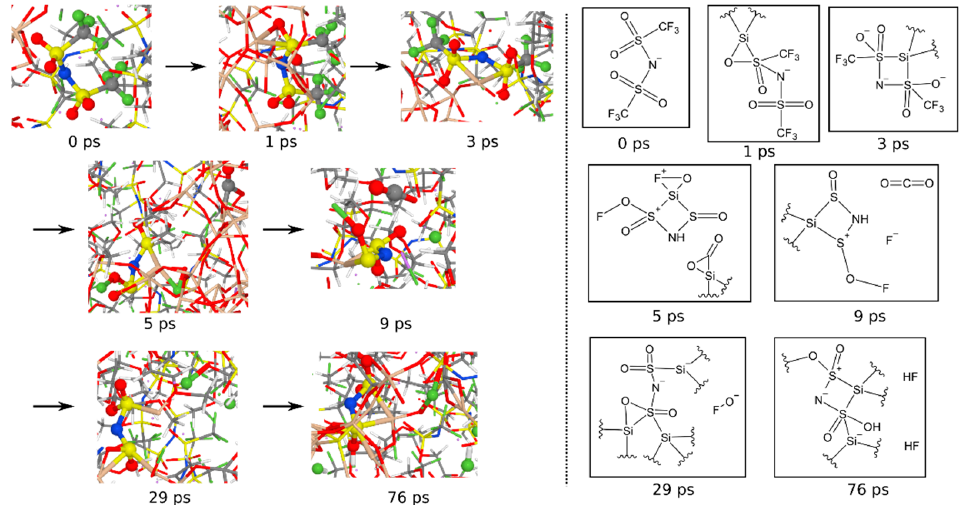
Figure 14. Decomposition of an exemplary chosen DME molecule. Shown are trajectory screenshots as well as the effective Lewis structures of the visible parts.